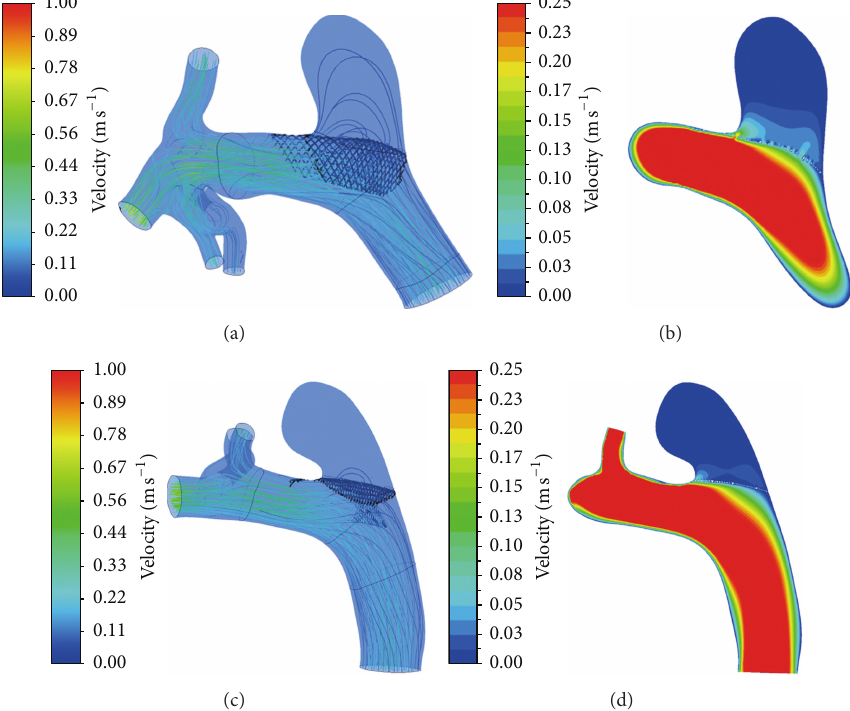
Figure 1: Computational fluid dynamics simulation based on micro-CT metal coverage measurement with in vivo flow diverter deployment. Inflow stream of the aneurysm sac and streamlines in < 35% metal coverage ((a) and (b)) and > 35% metal coverage ((c) and (d)) situations demonstrating lower mean inflow velocity with high metal coverage. Modified from [56].